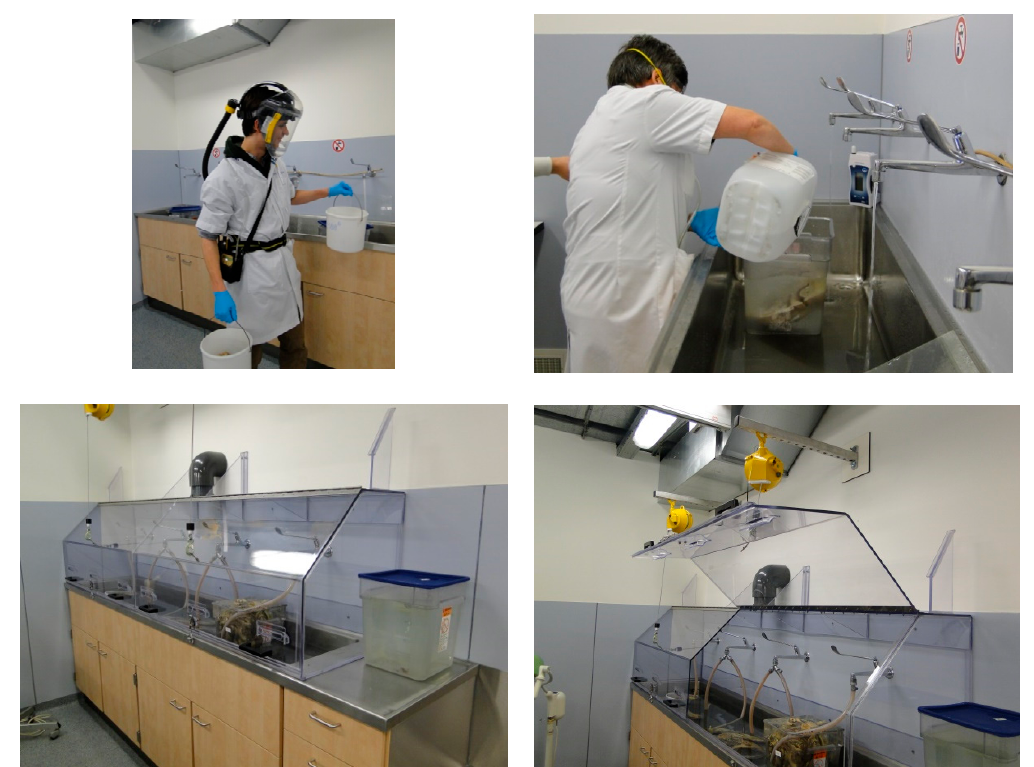
Figure 4. Before ( left panels ) and after ( right panels ) elimination of disposable absorbent sheets (red circle) and introduction of a containment system (instead of an open bucket) to collect leaking formalin residue (T-2 in Table 2).